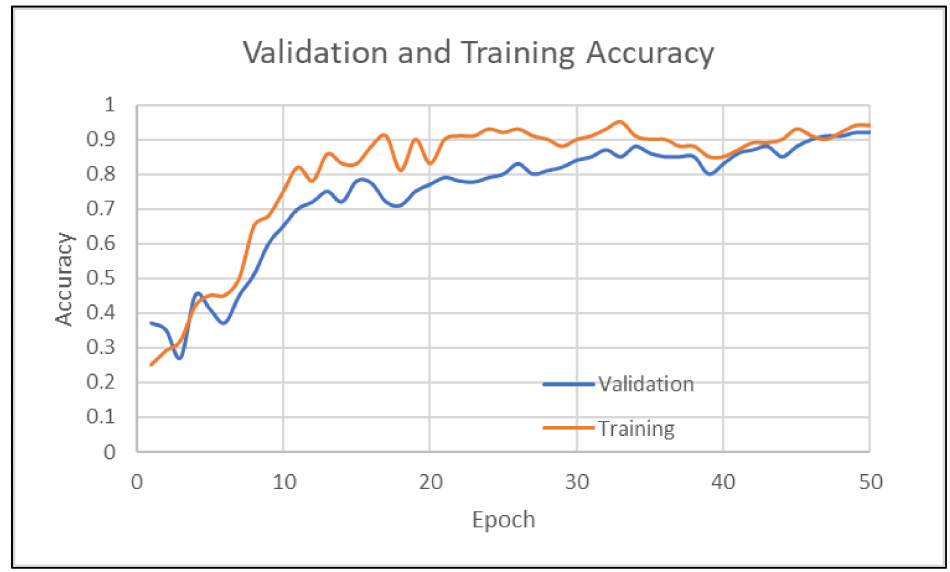
Figure 5. Validation and training